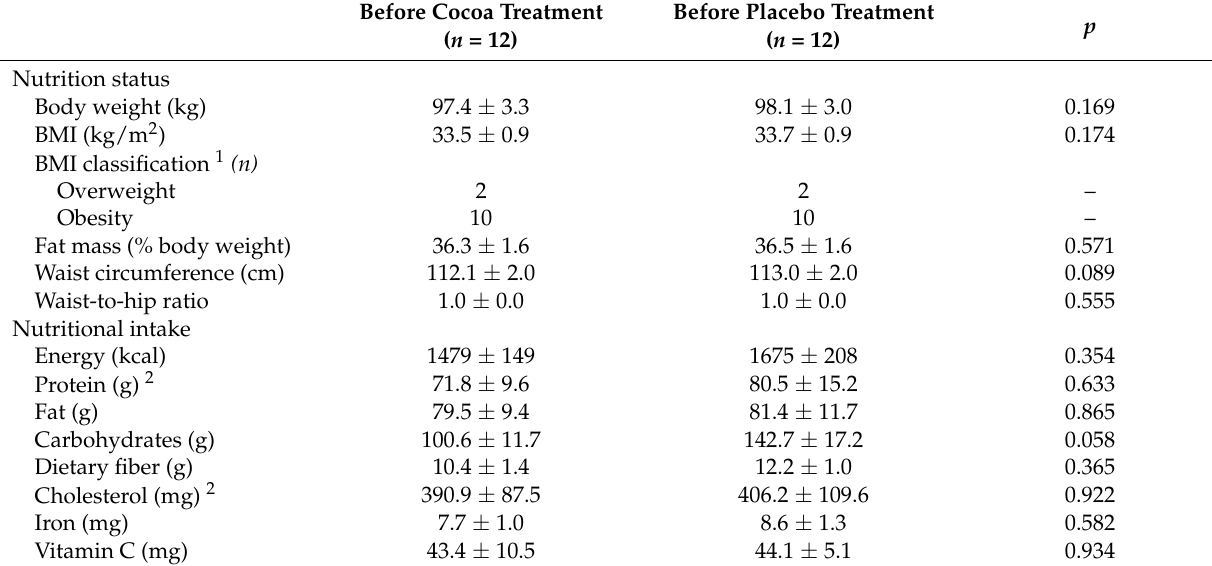
Table 4. Nutrition status in fasting state and nutritional intake on the previous day before each